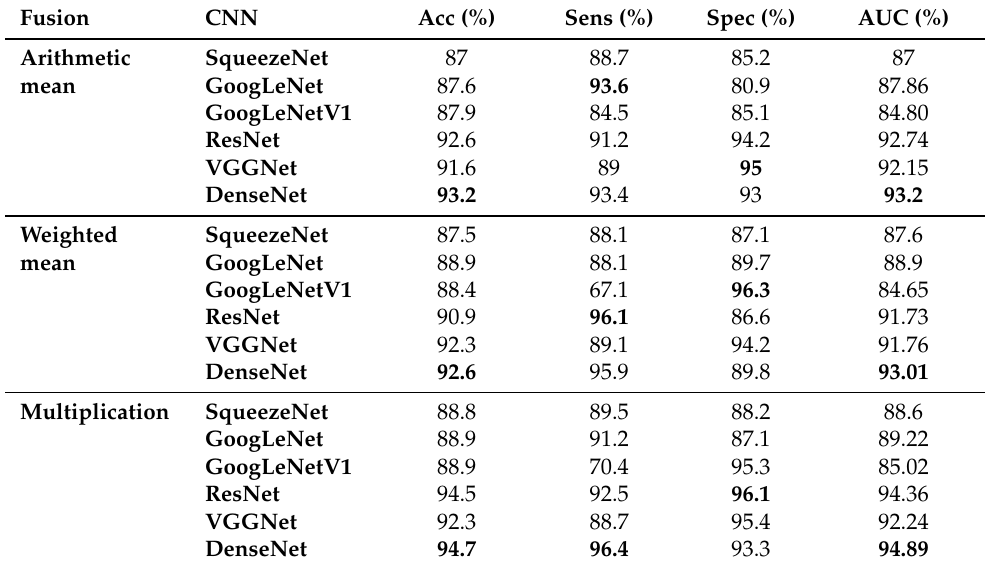
Table 3. The values of the classification performance parameters for CNNs when performing feature level